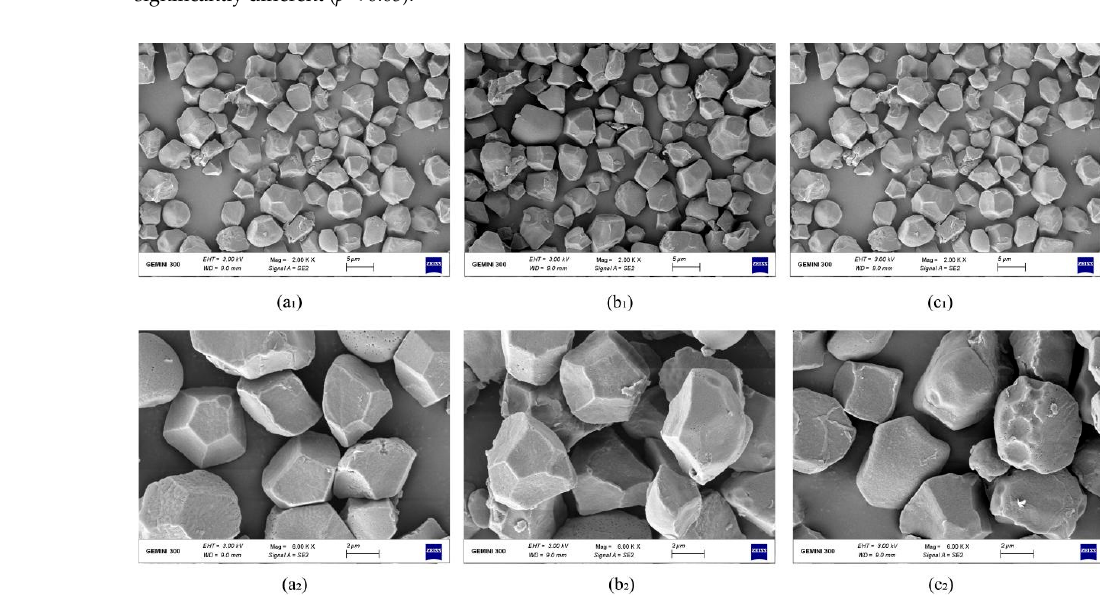
Table 3. Chain length distribution variation of rice amylopectin in storage.